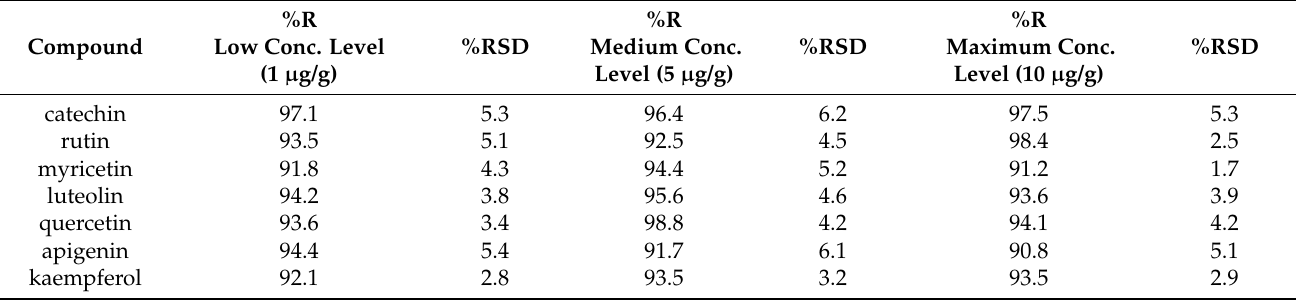
Table 2. %Recoveries (%R, n = 6) for the evaluation of repeatability.